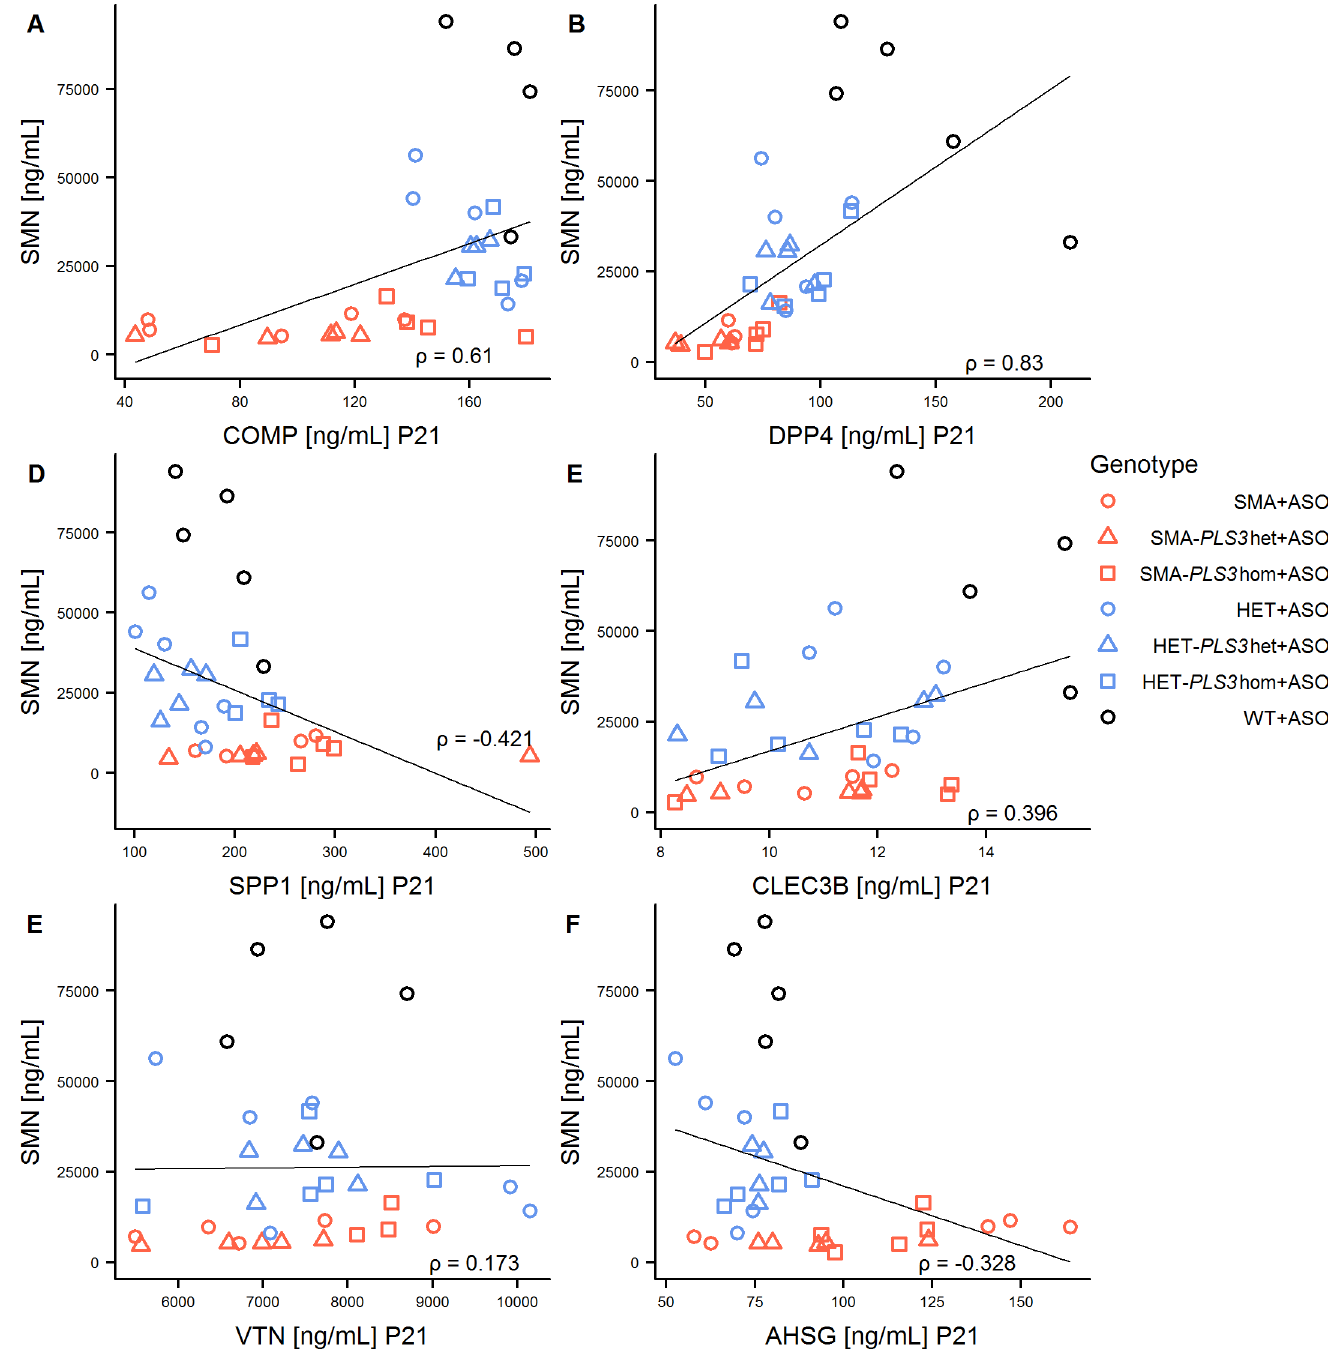
Fig 6. Correlations of SMN plasma protein with the concentration biomarkers at P21. (A) COMP, (B) DPP4, (C) SPP1, (D) CLEC3B, (E) VTN and (F) AHSG. A linear model is fitted into the plots and the Spearman’s Correlation Coefficient ρ for each linear model is given in S8 Table.